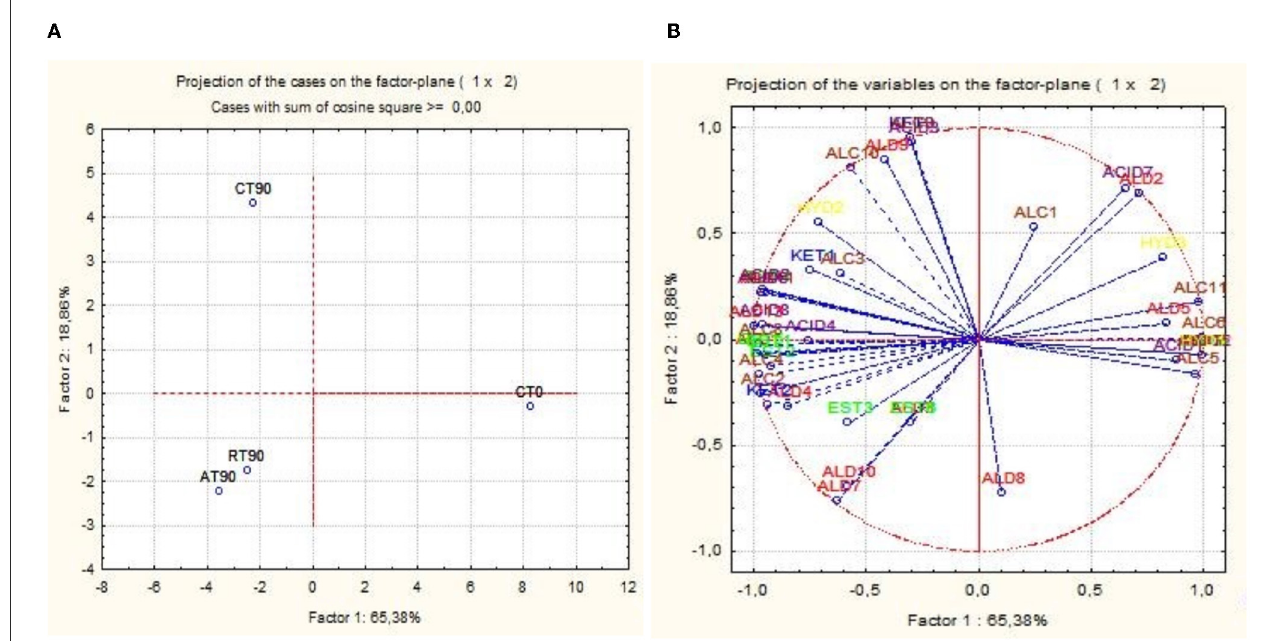
FIGURE6 Principal component analysis (PCA) scores (A) and loadings (B) plots of fermented sausages (CT0, meat mixture; CT90, control non-inoculated at 90 days; AT90, sausages inoculated with Lcb. casei N87 cultivated under anaerobiosis at 90 days; RT90, sausages inoculated with Lcb. casei N87 cultivated under respiratory conditions at 90 days) and volatile compounds. ALD1, Hexanal; ALD2, (E)-2-hexenal; ALD3, Octanal; ALD4, (z)-2-heptenal; ALD5, Nonanal; ALD6, (E)-2-octenal; ALD7, (E)-2-Nonenal; ALD8, (E)-2-decenal; ALD9, Benzenacetaldehyde; ALD10, 2,4-Nonadienal; ALD11, 2-undecenal; ALD12, (E,E)-